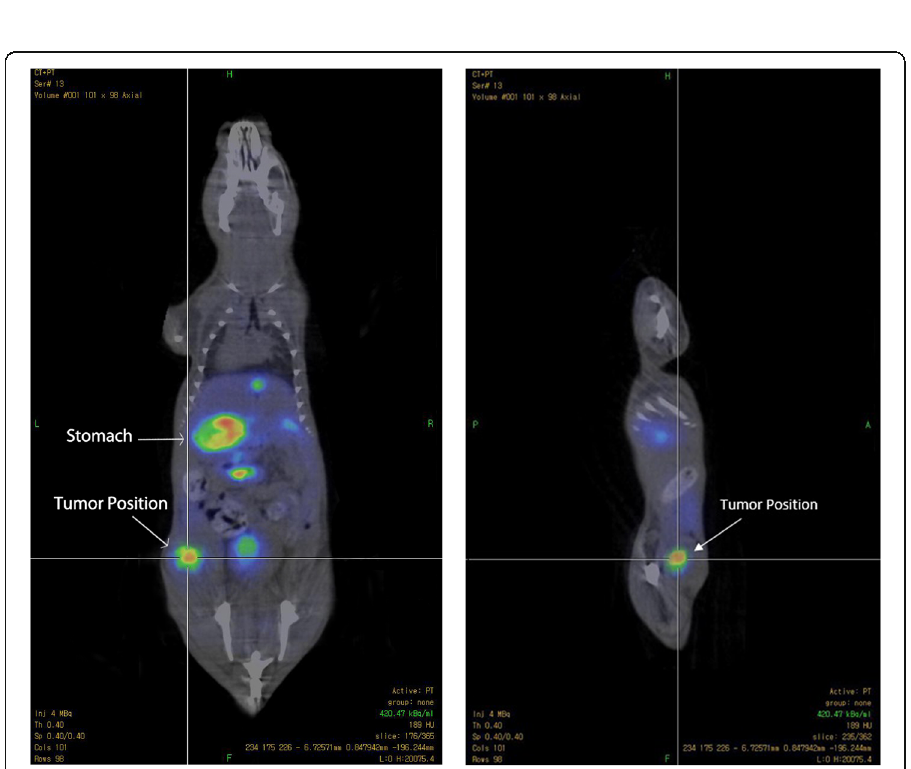
Fig. 4 Coronal and sagittal images of tumor-bearing mouse after 1 h post-injection using 5 MBq MUC1-[ 18 F] SFB peptide